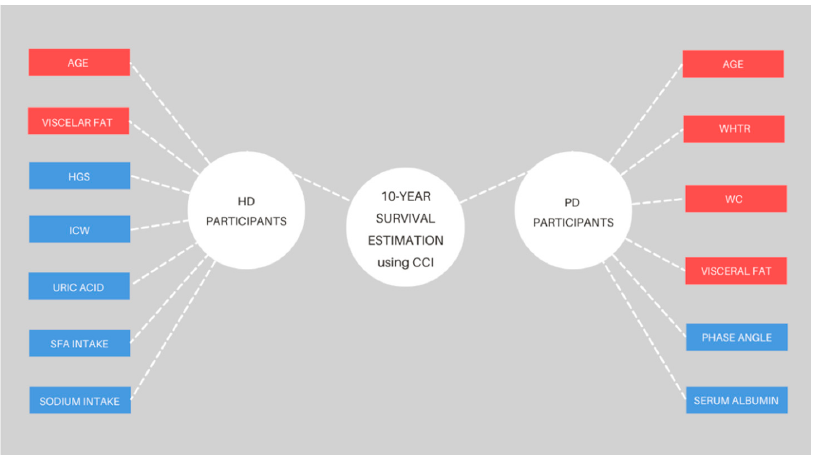
Figure 3. Significant correlations of the 10-year survival estimation and measured parameters for